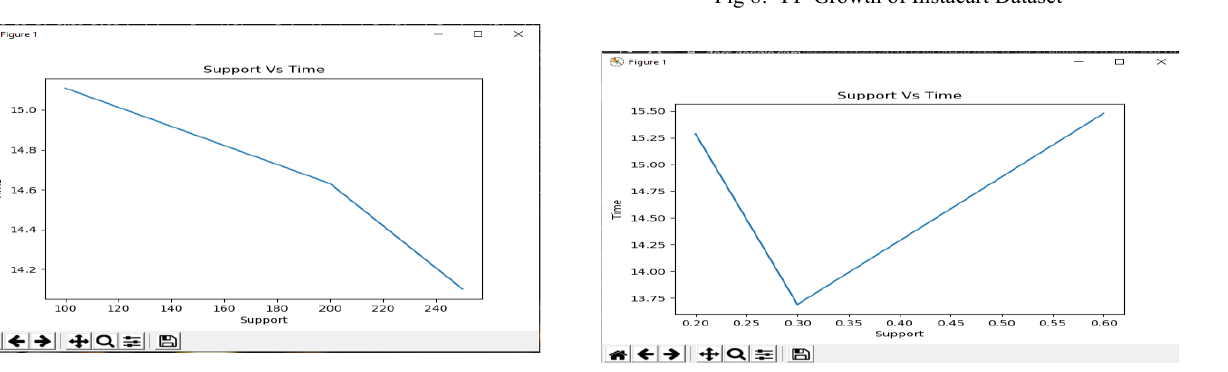
Fig 5:- Apriori Of Online Retail I Dataset